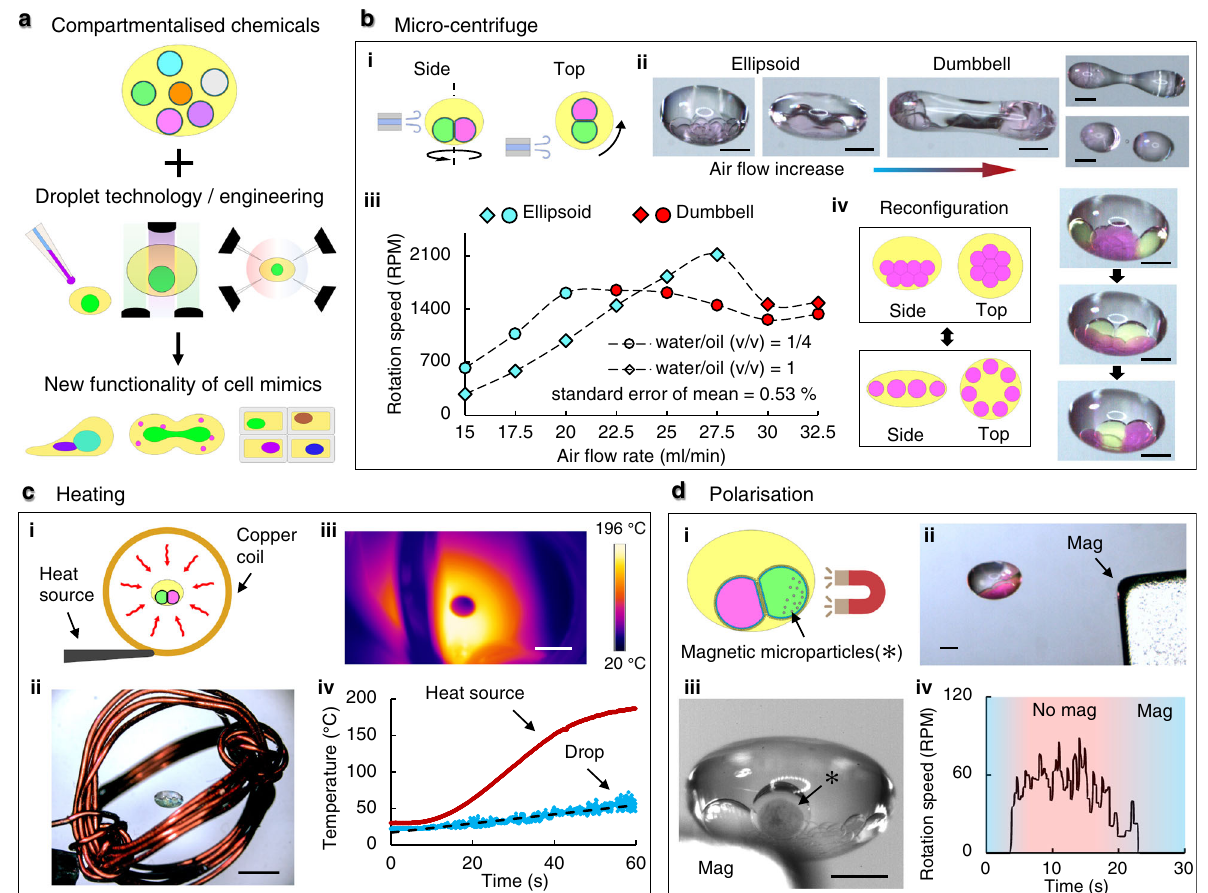
Fig. 3 Multiple operations on levitated ACDC droplet. a The combination of controlled chemical compartmentalisation, with subsequent droplet processing and manipulation, as methods to energise the droplet structures, can be used to impart function on the resulting materials. b